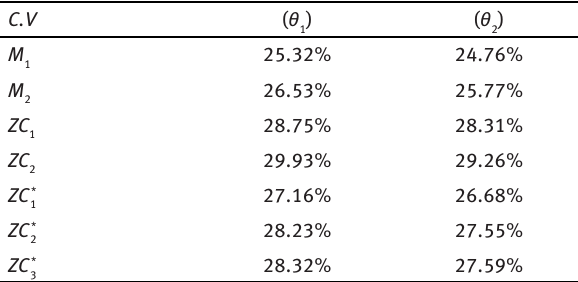
Table 3: Different values of C.V of the indicated Zagreb indices for both operations T